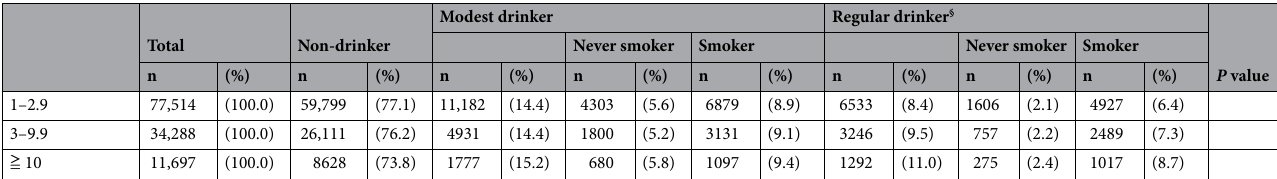
Table 1. Demographics and clinical characteristics by drinking status. § Regular Drinker include ex-drinker group.